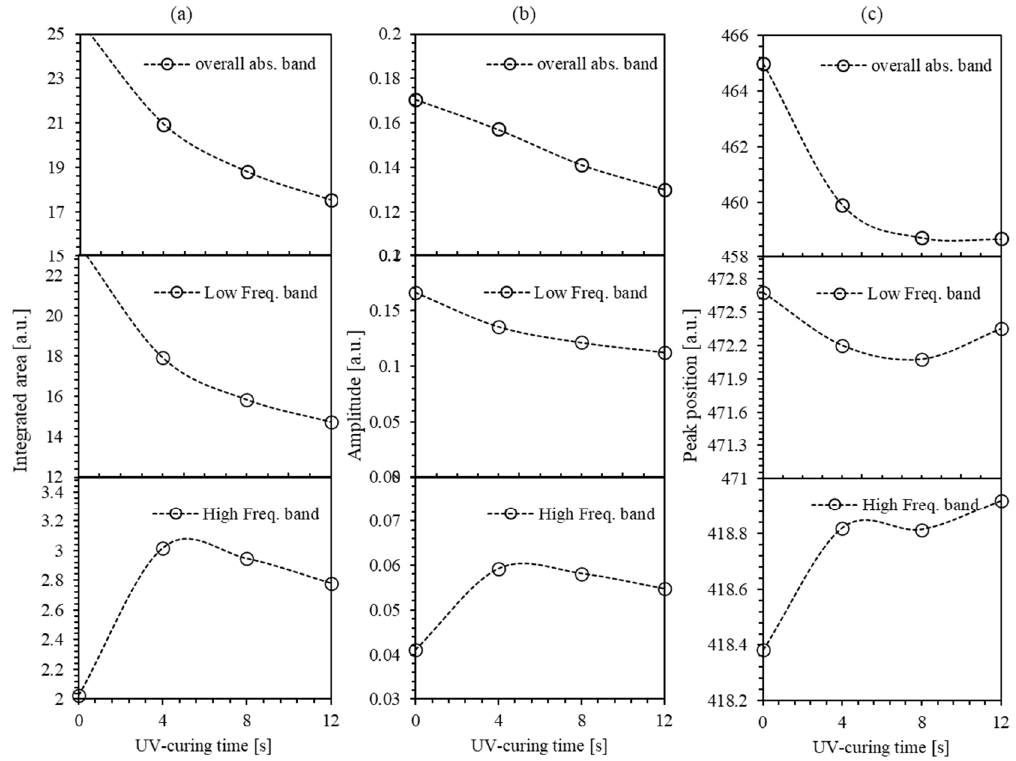
Figure 6. ( a – c ) Double peaks fit of the absorbance spectra of PMMA-BDK-MR polymer composite thin film for various UV-illumination times. film for various UV-illumination